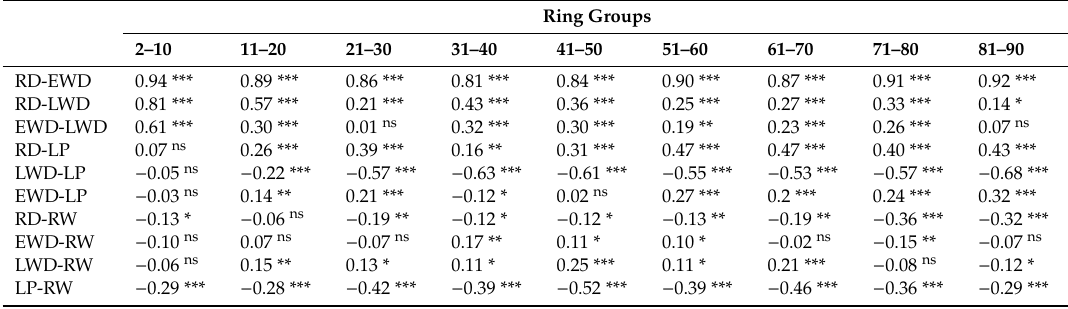
Table 5. Pearson correlation coe ffi cients between ring density components and ring widths for selected ring groups in T. occidentalis and their statistical